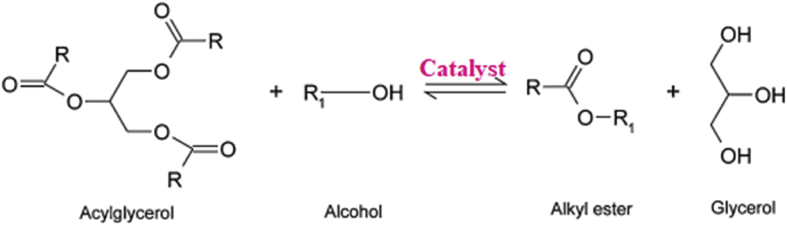
A typical transesterification reaction (Lourinho and Brito, 2015).